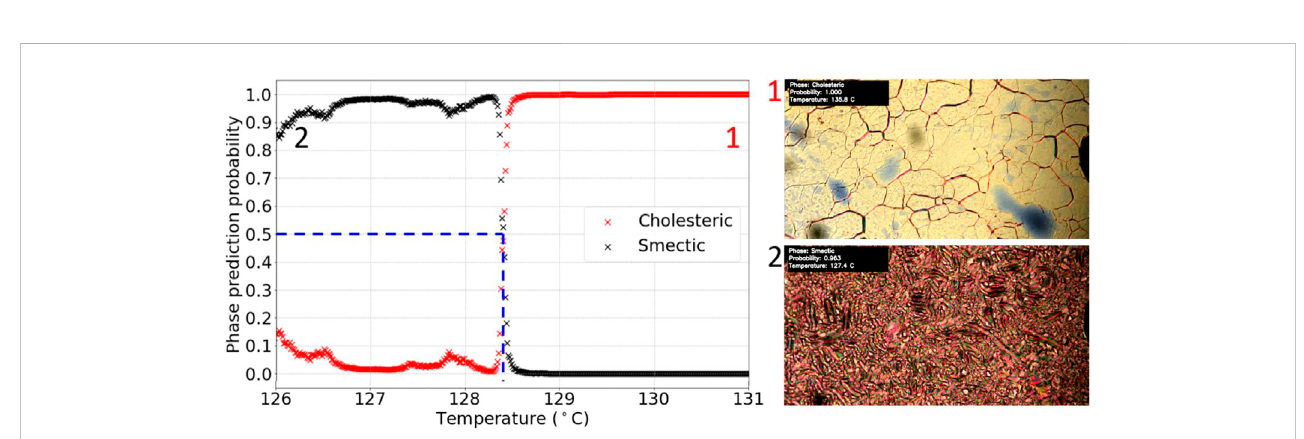
FIGURE 7 Graph of phase prediction probability against temperature for a labelled N*-SmC* transition test video. The vertical dashed line shows the identi fi ed transition